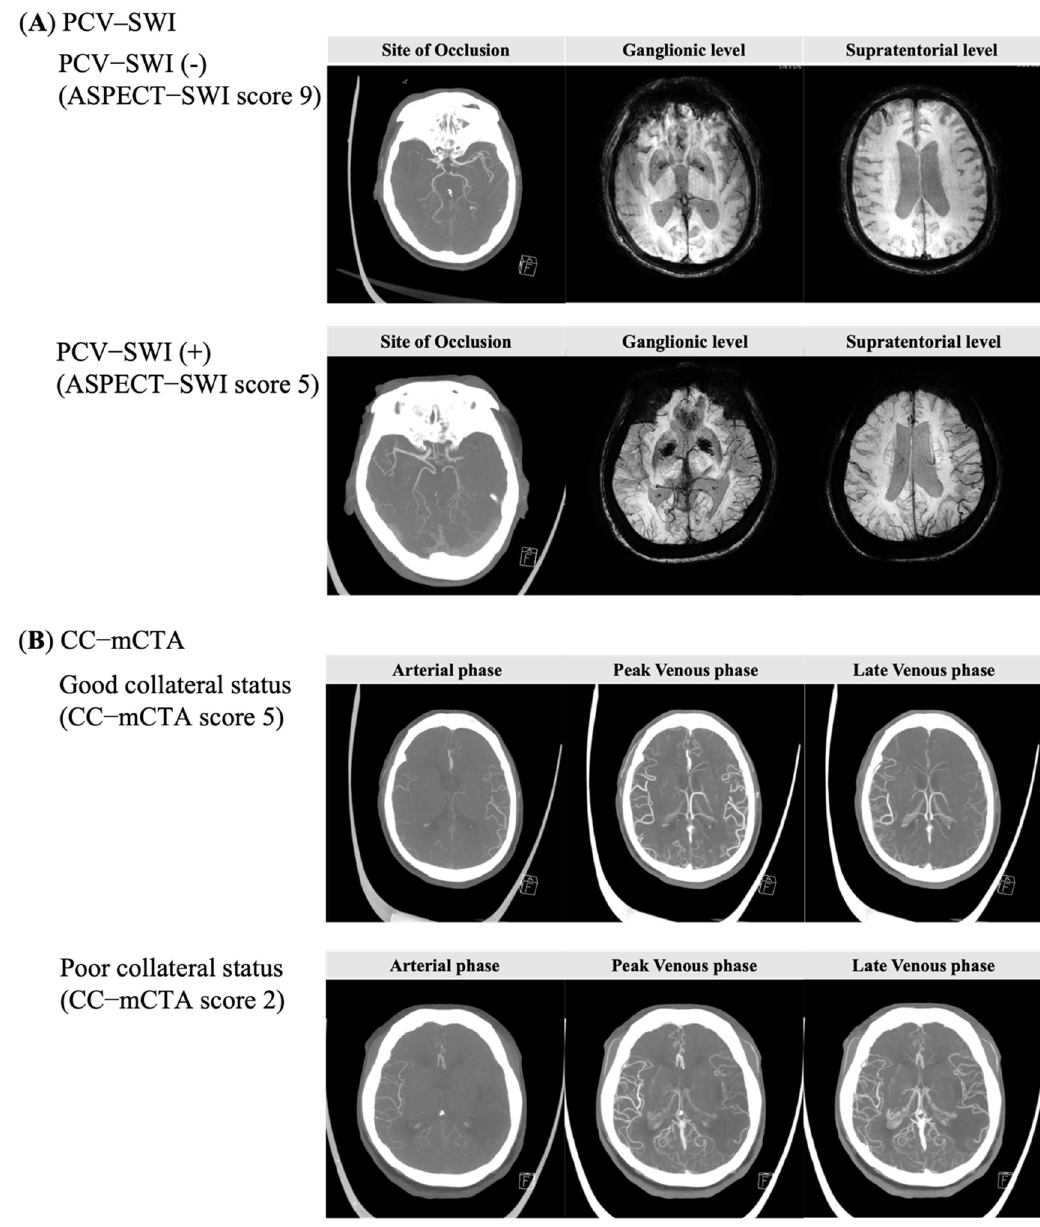
Figure 1. PCV–SWI ( A ), CC–mCTA ( B ).